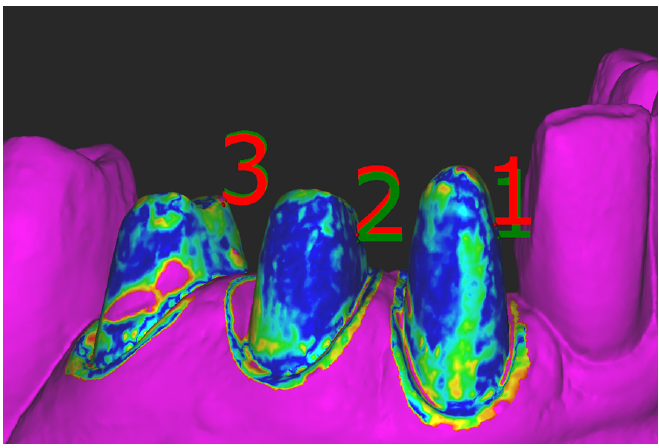
Figure 10. Alignment of the two STL files.